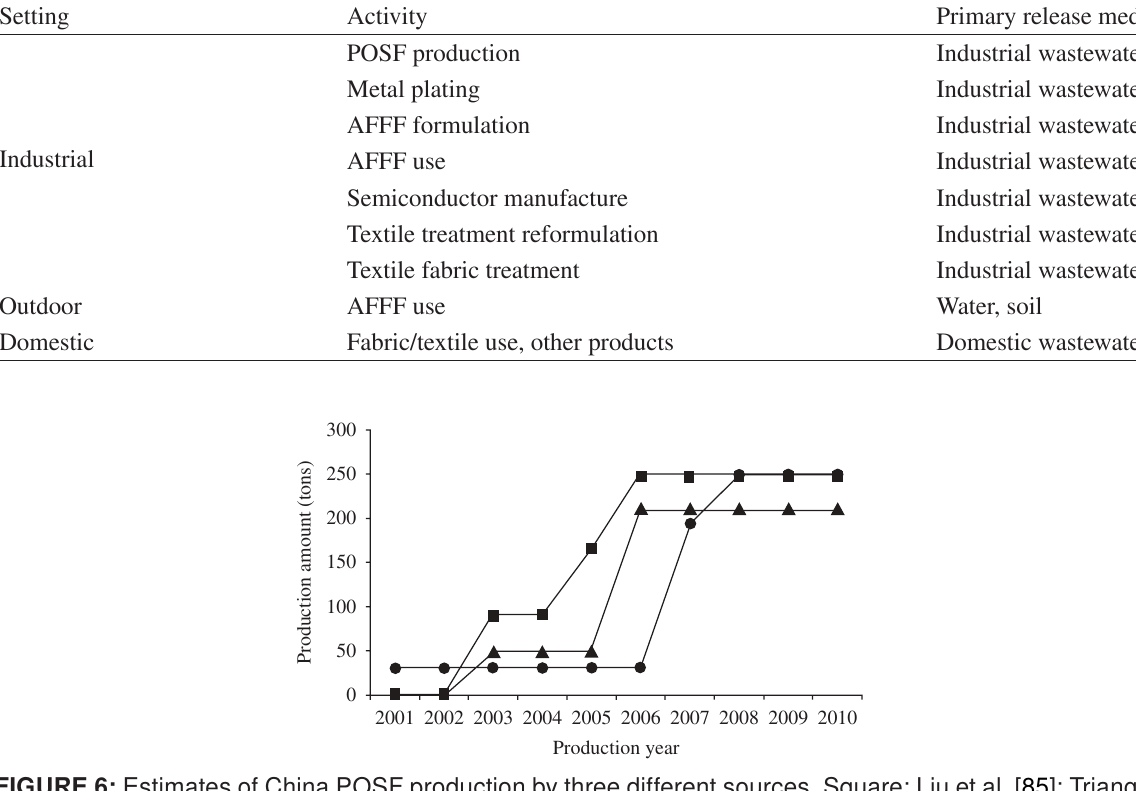
TABLE 3: Important use areas for preliminary PFOS emissions inventory for China.